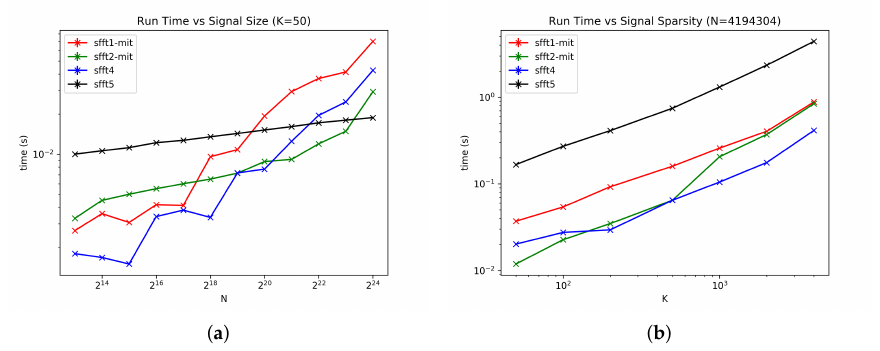
Figure 4. The run time vs. signal size and vs. signal sparsity for the sFFT1.0, sFFT2.0, sFFT4.0, and sFFT5.0 algorithms in the general sparse case. ( a ) run time vs. signal size; ( b ) run time vs. signal sparsity.